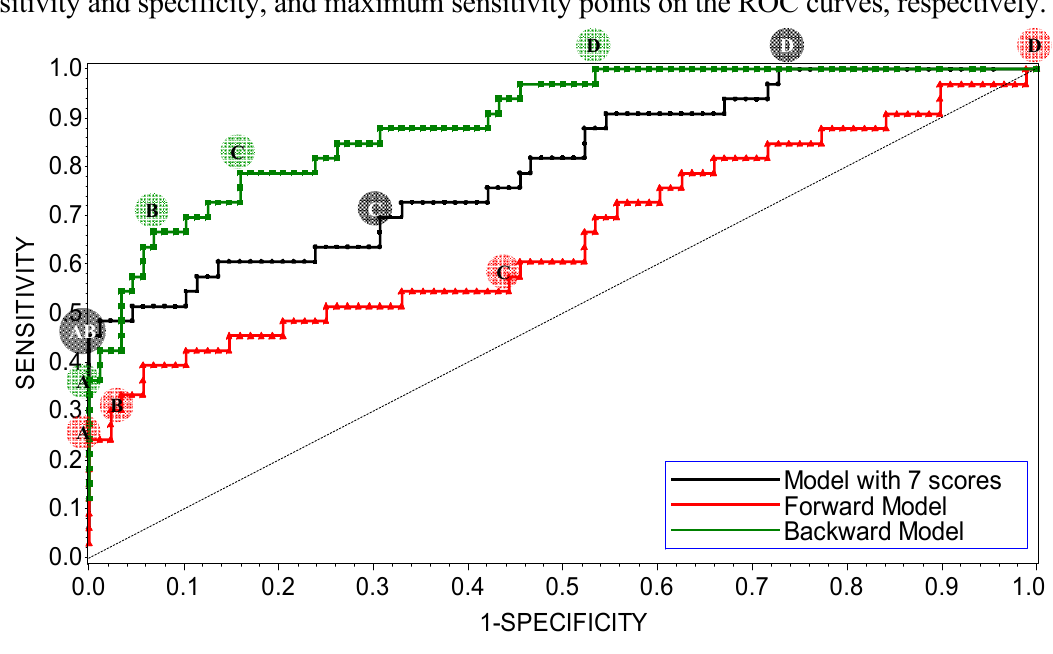
Figure 2. ROC plot of the interim DLR models for potent and weak inhibitors of CYP3A4. A, B, C, and D denote maximum specificity, maximum correct classification, equal sensitivity and specificity, and maximum sensitivity points on the ROC curves,